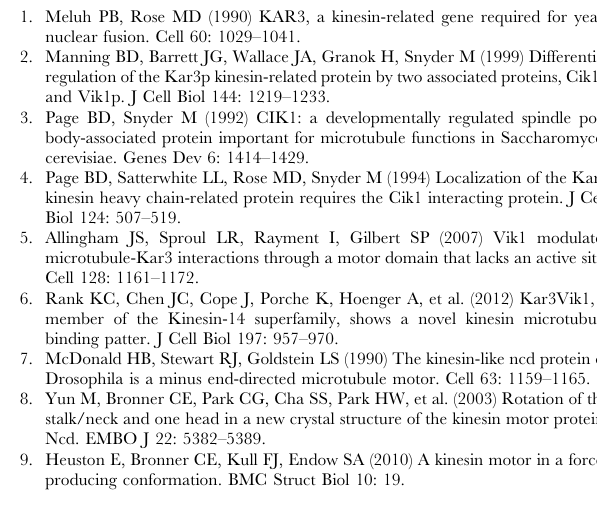
Figure S1 Helical averages of Kar3Vik1-decorated MTs in three different nucleotide states. The left panel shows 2D projections through the helical reconstructions of Kar3Vik1 bound to MTs in the nucleotide-free (A), AMPPNP (B), and ADP-AlF4- (C) states, with their corresponding Fourier transforms in the right panel. Figure S2 Plots of amplitudes and phases show averag- es comprise high-quality data. The amplitudes (solid lines) and phases (dotted lines) of each of the layer lines of the final helical averages of Kar3Vik1 bound to MTs in the nucleotide-free (A) and AMPPNP (B) states. The amplitudes indicate the contribution of each layer line to the average. Relatively little scattering in the phase plots shows that the average is composed of good quality data. Figure S3 Phase plots reveal the resolution limit of the data. Phase plots for three selected layer lines of all the individual datasets included in the final nucleotide-free (A) and AMPPNP (B) state helical reconstructions (each dot is one phase value). The clustering of datasets at certain phases reflects reliable data while areas with scattered phases are considered noise. The resolution limit of the 3D maps can thus be determined from these plots to be , 2.5–2.2 nm.